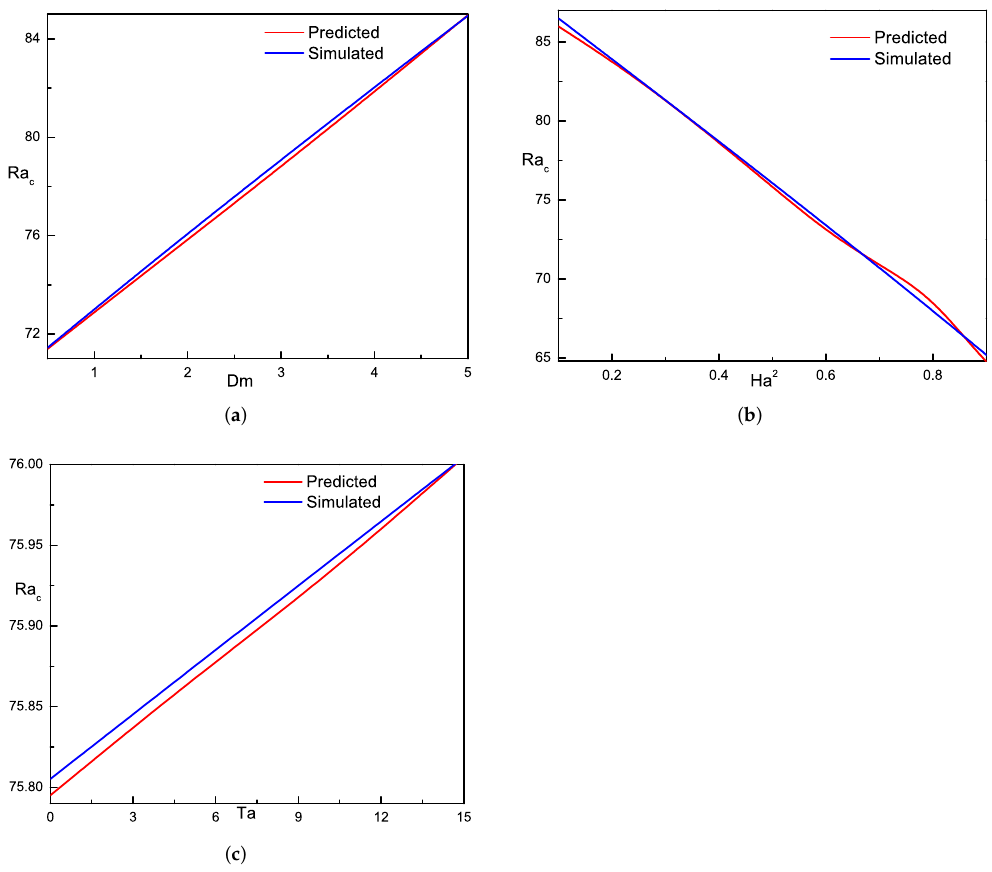
Figure 12. Comparison of the simulated and ANN-predicted critical Rayleigh number values for ( a ) Dm , ( b ) Ha , and ( c ) Ta